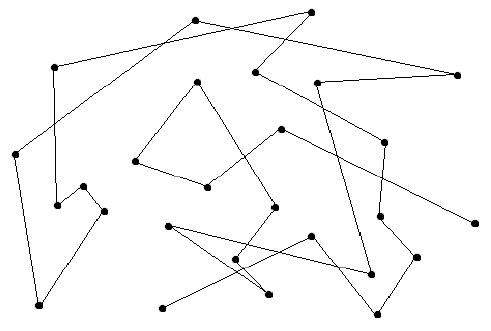
Figure 30. An illustration of the random motion of a singular nanoparticle caused by Brownian